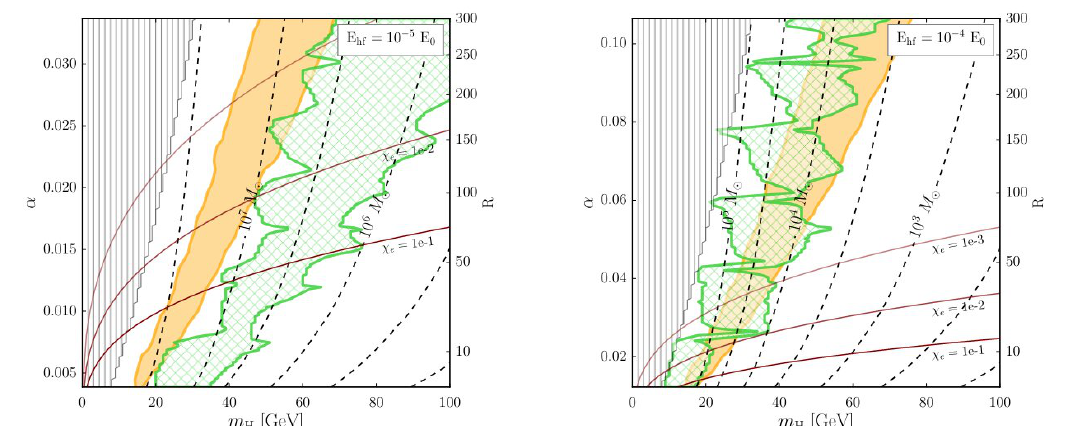
Figure 4: Regions of α (cid:48) versus m (orange) and lower mass halos (green), for E taken from Ref. [ 32 ] . Contours of ionization fraction (here called χ well as contours of the minimum halo masses that can form, due to DAO and the dark analog of Silk damping, assuming a dark temperature ratio of ξ =